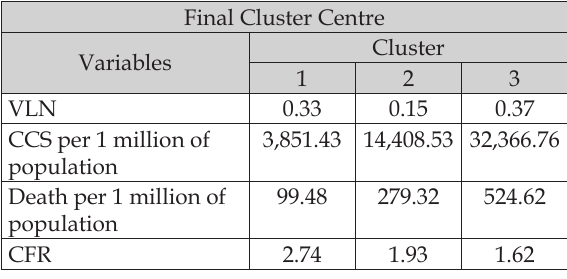
mulative cases Source: own